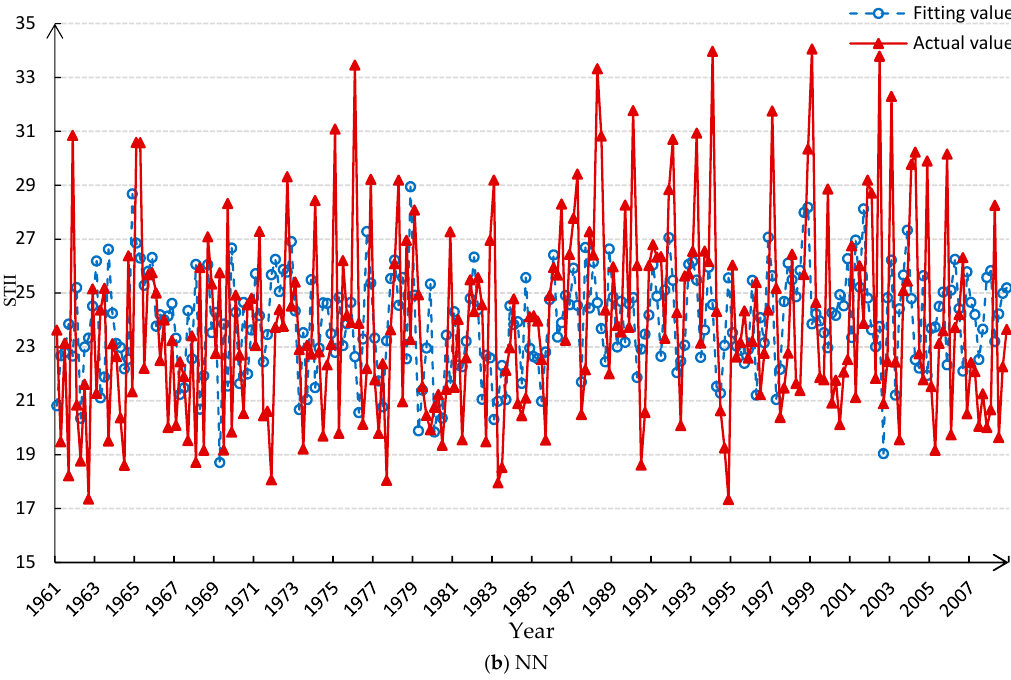
Figure 8. Comparative fitting results between WA-DBN and NN.